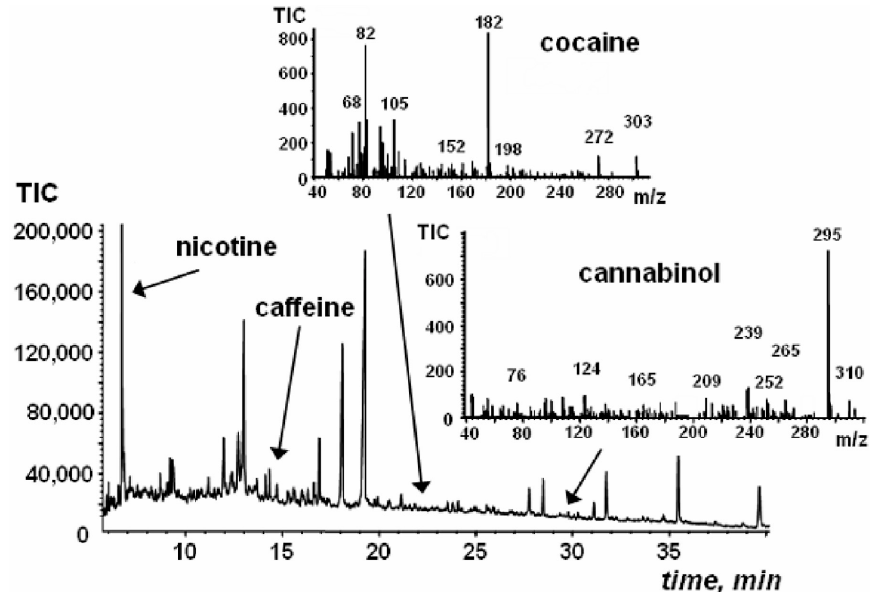
Figure 2. GC/MS profile of the highly-polar organic fraction associated with airborne particulate from a green park in downtown Rome. Insert: mass spectra of cocaine and cannabinol. With permission from [40].